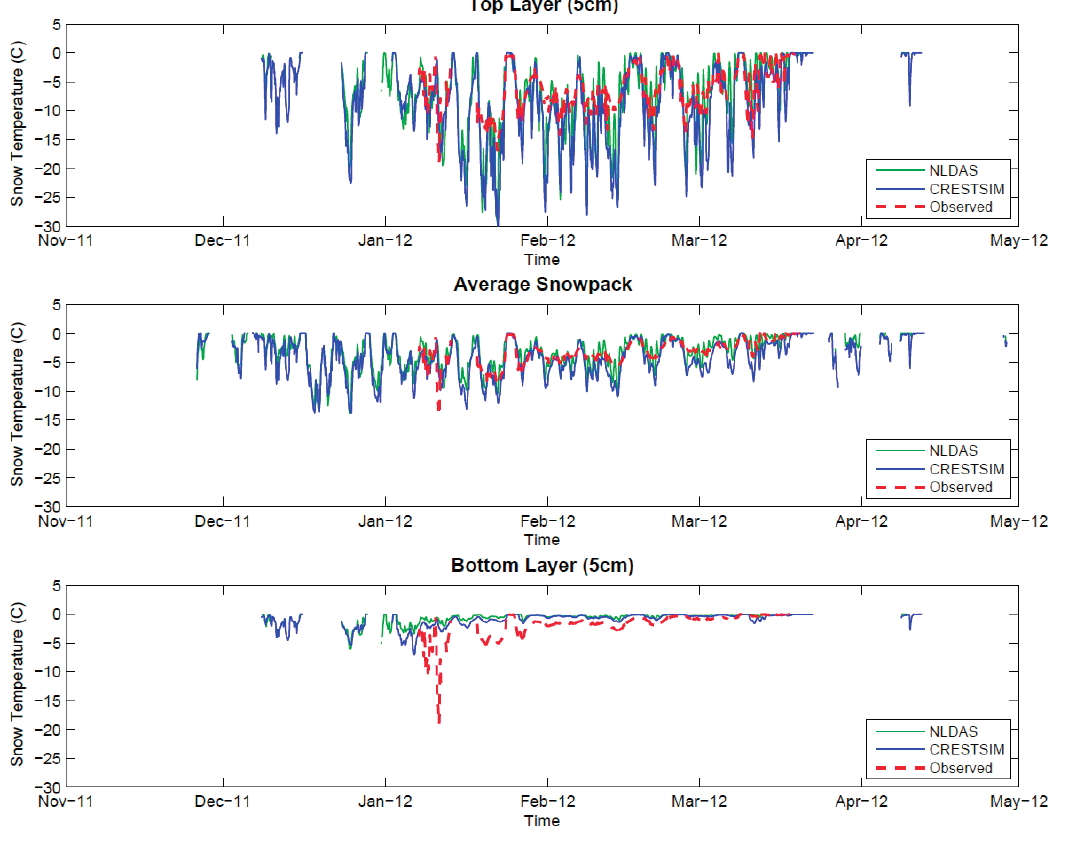
Figure 10. Time series for temperature (°C) in the top layer ( upper ), average ( middle ), and bottom layer ( lower ) of the snowpack. Legend: NLDAS meteorological data simulation (NLDAS), CREST-SAFE meteorological data simulation (CRESTSIM), and manual CREST- SAFE Observations